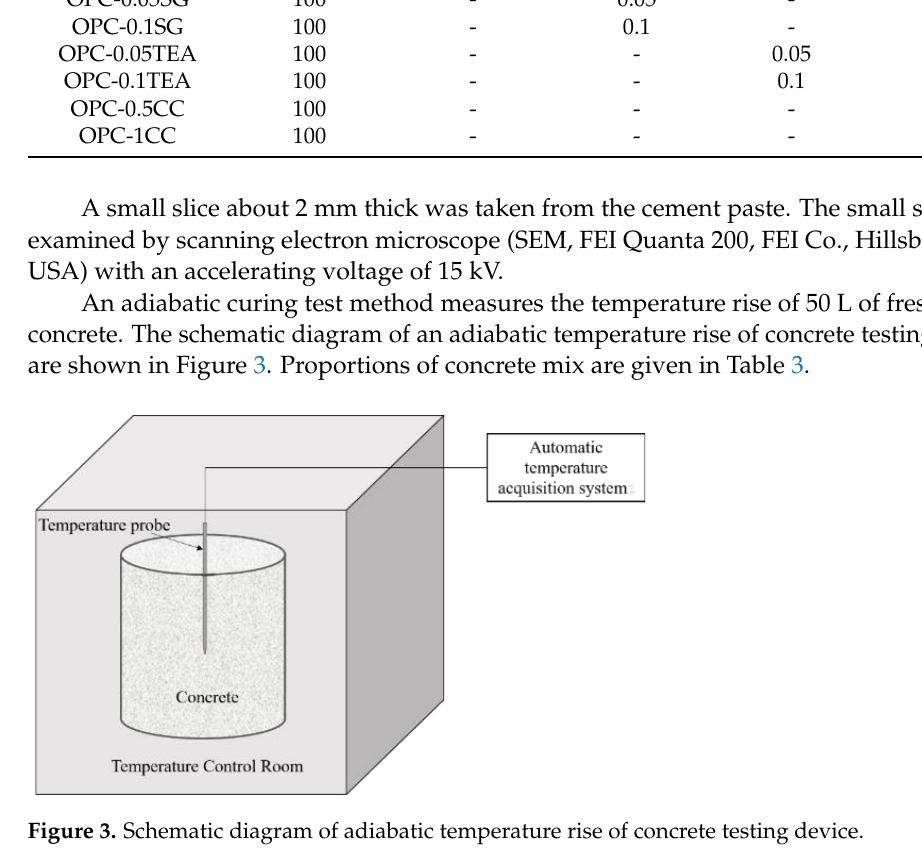
Table 2. Composition of mixes (wt.%).